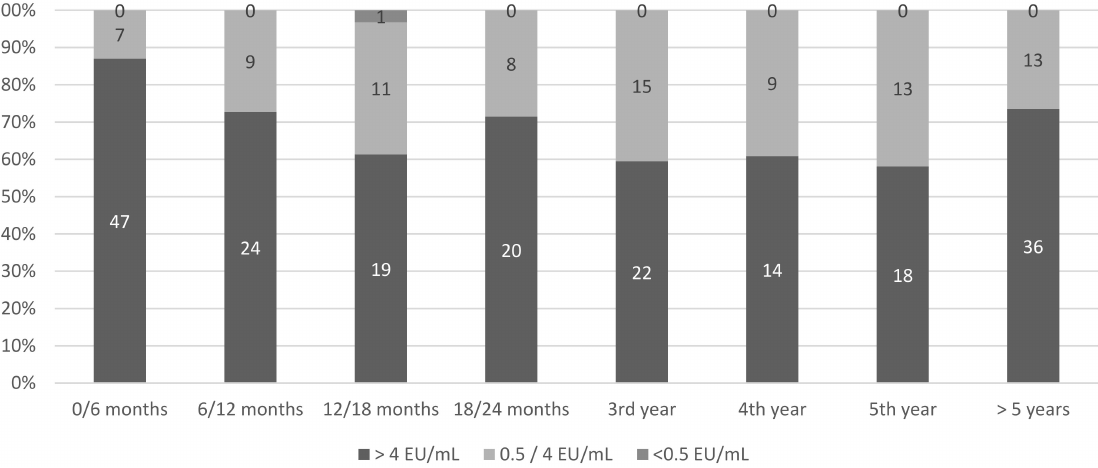
Figure 3. Percentage and number of antibody titers assessed after rabies primary vaccination and a single booster by titer categories and time-lapse since booster, in individuals vaccinated for occupational purposes ( n = 286), Institut Pasteur, Paris